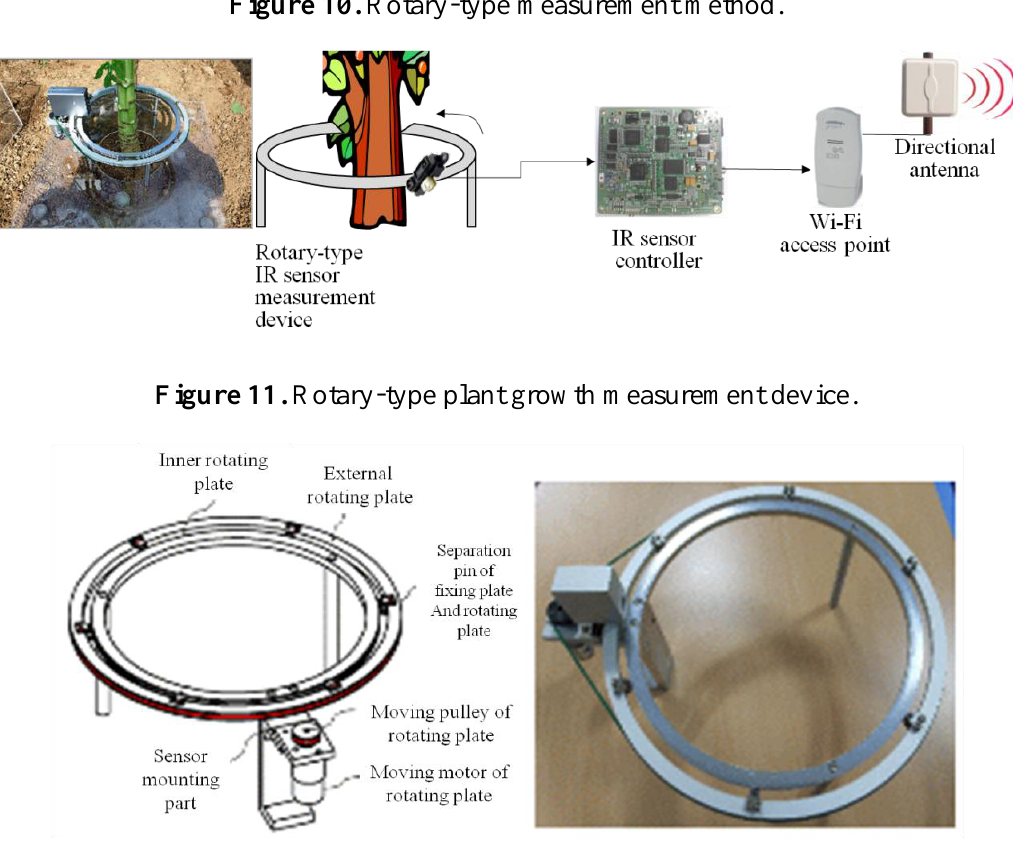
Figure 10. Rotary-type measurement method.